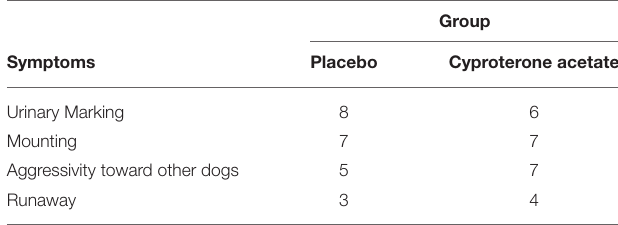
TABLE 3 | Numbers of subjects by symptoms in the two treatment